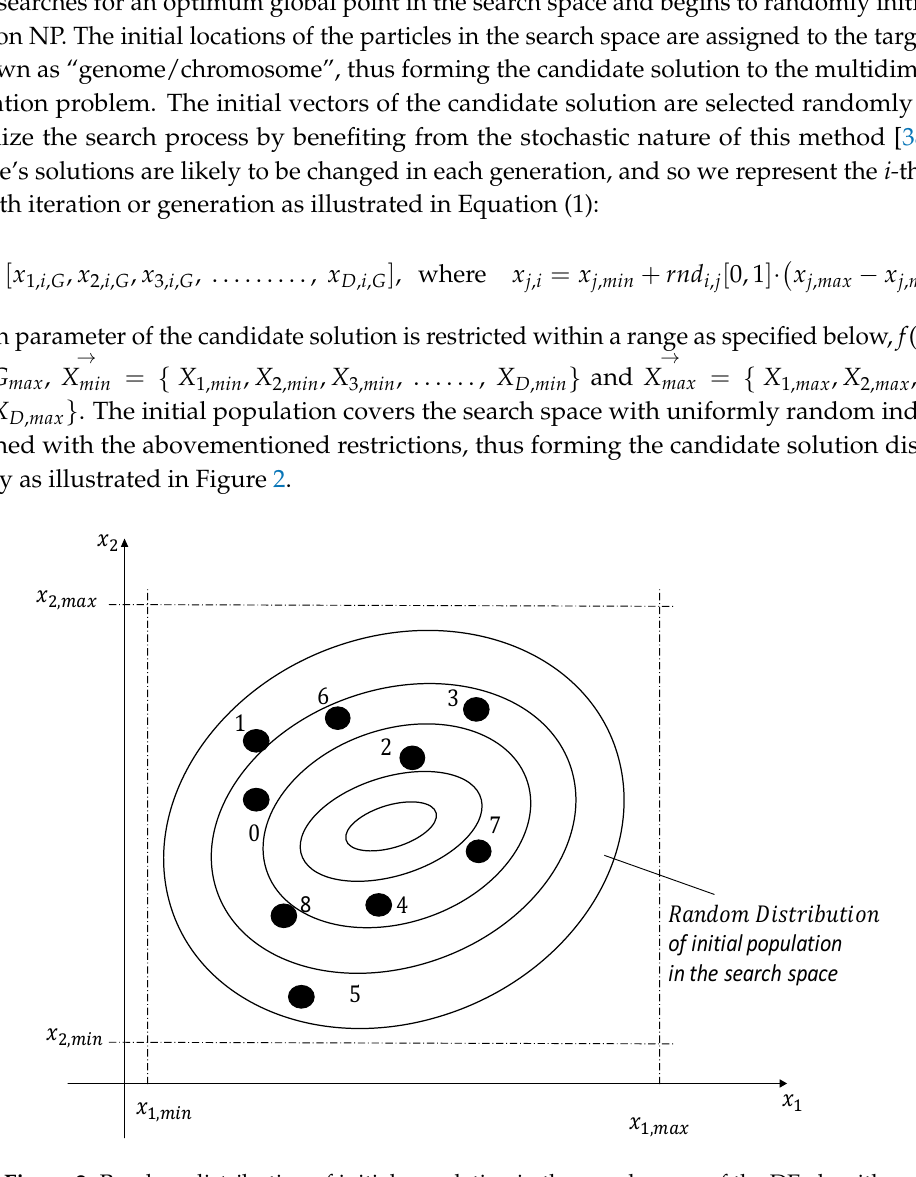
Figure 2. Random distribution of initial population in the search space of the DE algorithm.